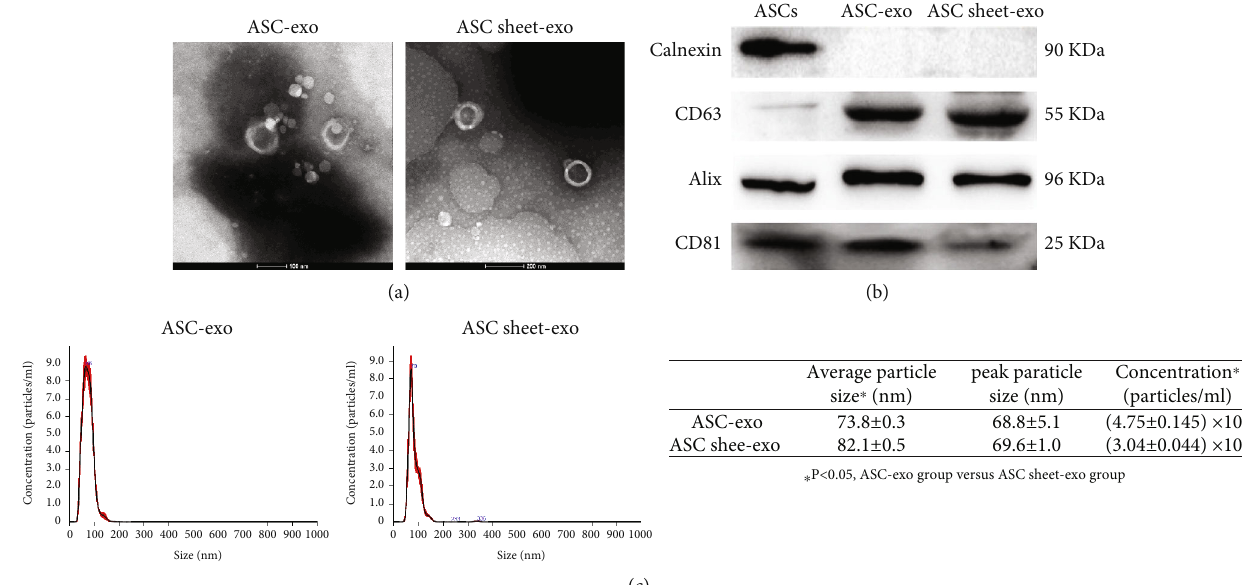
Figure 11: Characterization of ASC-exo and ASC sheet-exo. (a) Representative TEM images of ASC-exo and ASC sheet-exo. (b) Western blotting analysis of exosomal marker proteins (CD63, Alix, and CD81), and the negative marker (Calnexin) of ASC-exo and ASC sheet-exo. (c) Particle size distribution of ASC-exo and ASC sheet-exo measured by